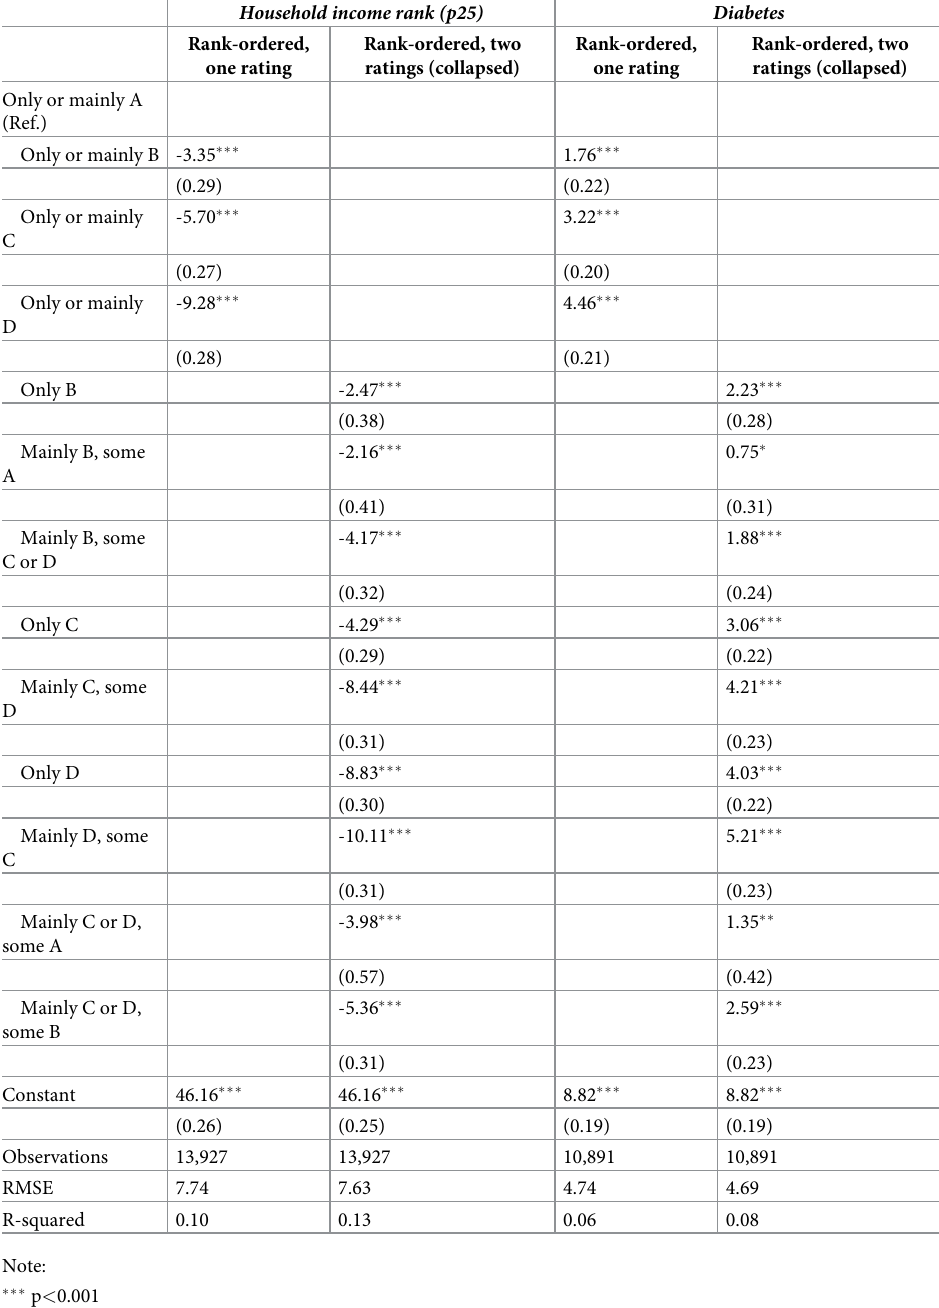
Table 6. OLS regression coefficients and standard errors from regressions of census tract level adult household income ranks (Opportunity atlas) and diabetes diagnoses (500 cities) on two census tract HOLC classifications. Household income rank (p25) Diabetes Rank-ordered, Rank-ordered, two Rank-ordered, Rank-ordered, two one rating ratings (collapsed) one rating ratings (collapsed) Only or mainly A